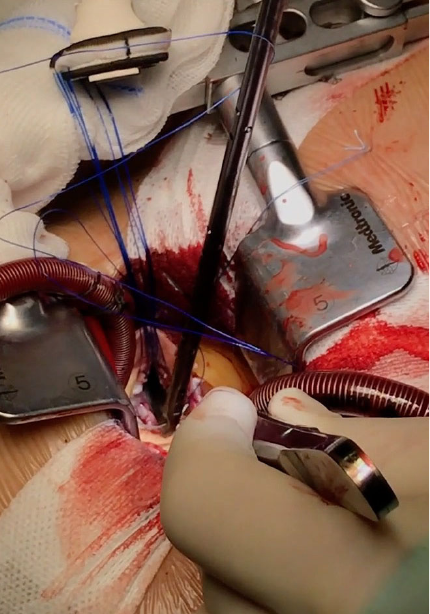
Fig. 7 - Diseased aortic valve